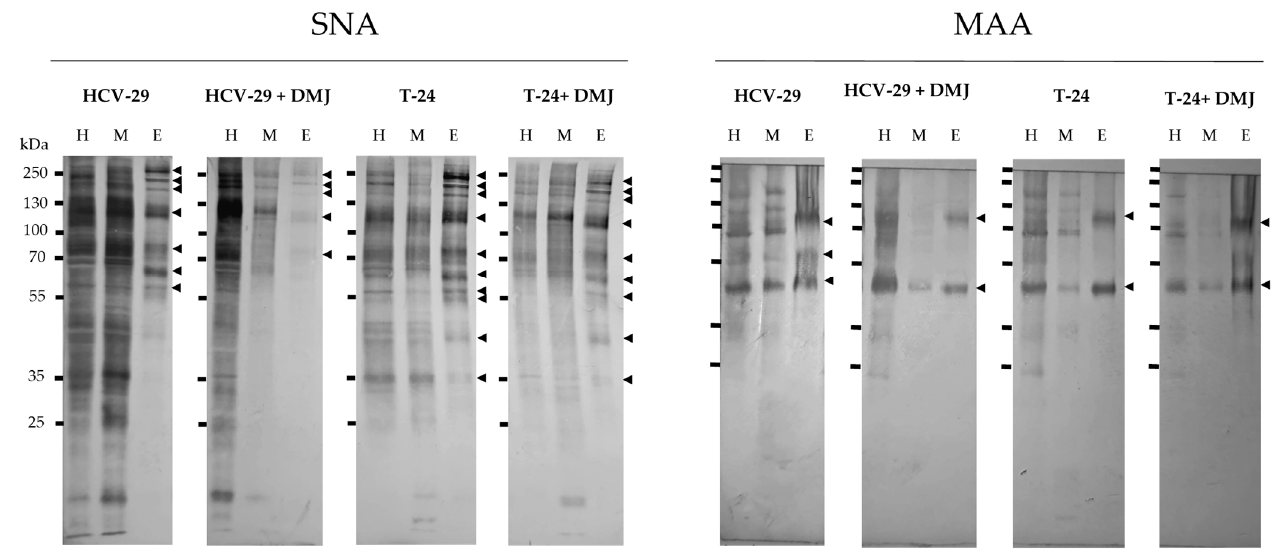
Figure 5. Detection of glycoproteins carrying α 2,6-linked (SNA-positive) and α 2,3-linked (MAA- positive) sialic acids. Results of lectin blotting with SNA and MAA are shown in the Figure. Controls with the competitive sugars are shown in Supplementary Data (Figure S2). The major specific bands were indicated on the right with arrowheads. H, the whole cell protein extract; M, the membrane fraction; E, the ectosomal fraction.